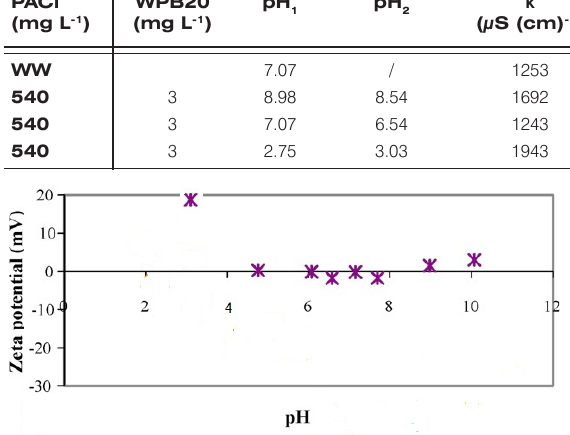
Table 5. Measurements when using PACl and Organopol WPB20 at different pH’s. PACl (mg L -1 )